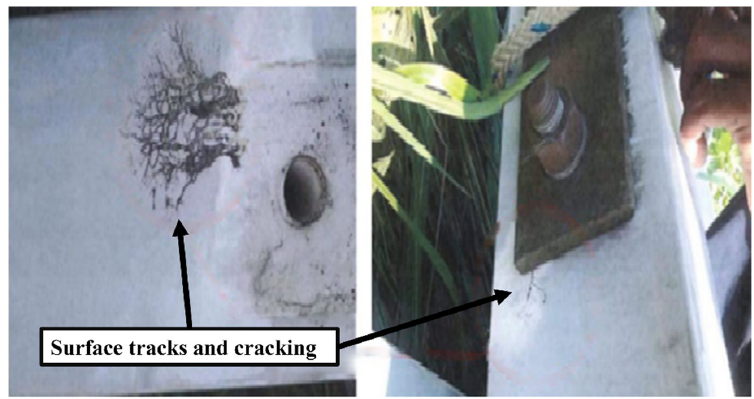
Figure 23. Surface tracking and cracks on the composite cross